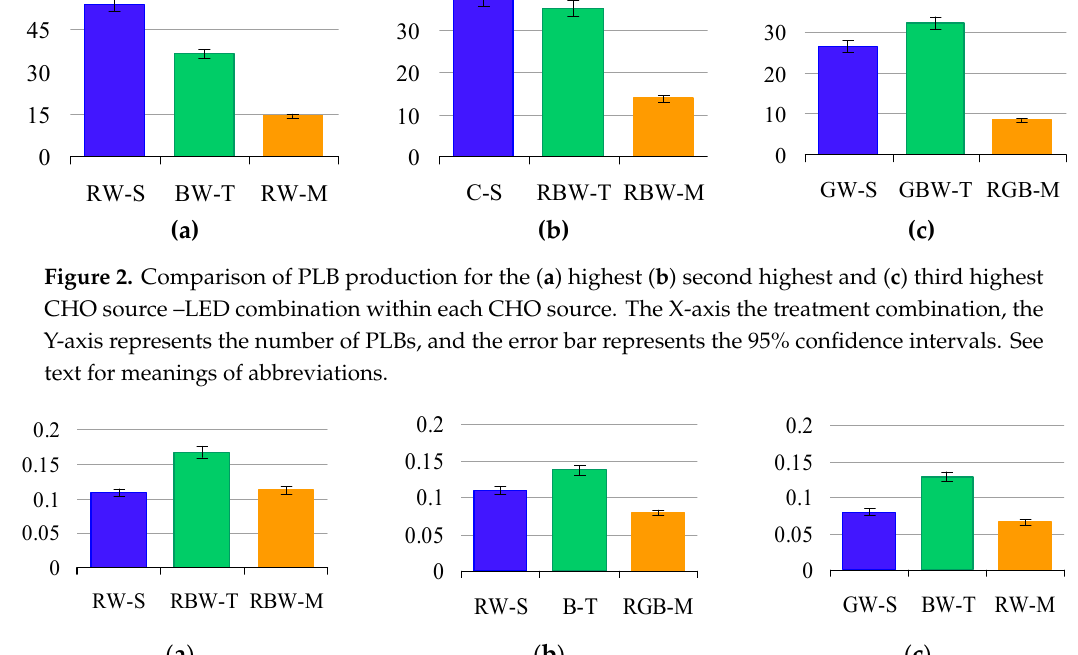
Figure 3. Comparison of fresh weight for the ( a ) highest ( b ) second highest and ( c ) third highest within CHO source –LED combination each CHO source. The X-axis the treatment combination, the Y-axis represents the number of PLBs, and the error bar represents the 95% confidence intervals. See text for meanings of abbreviations.